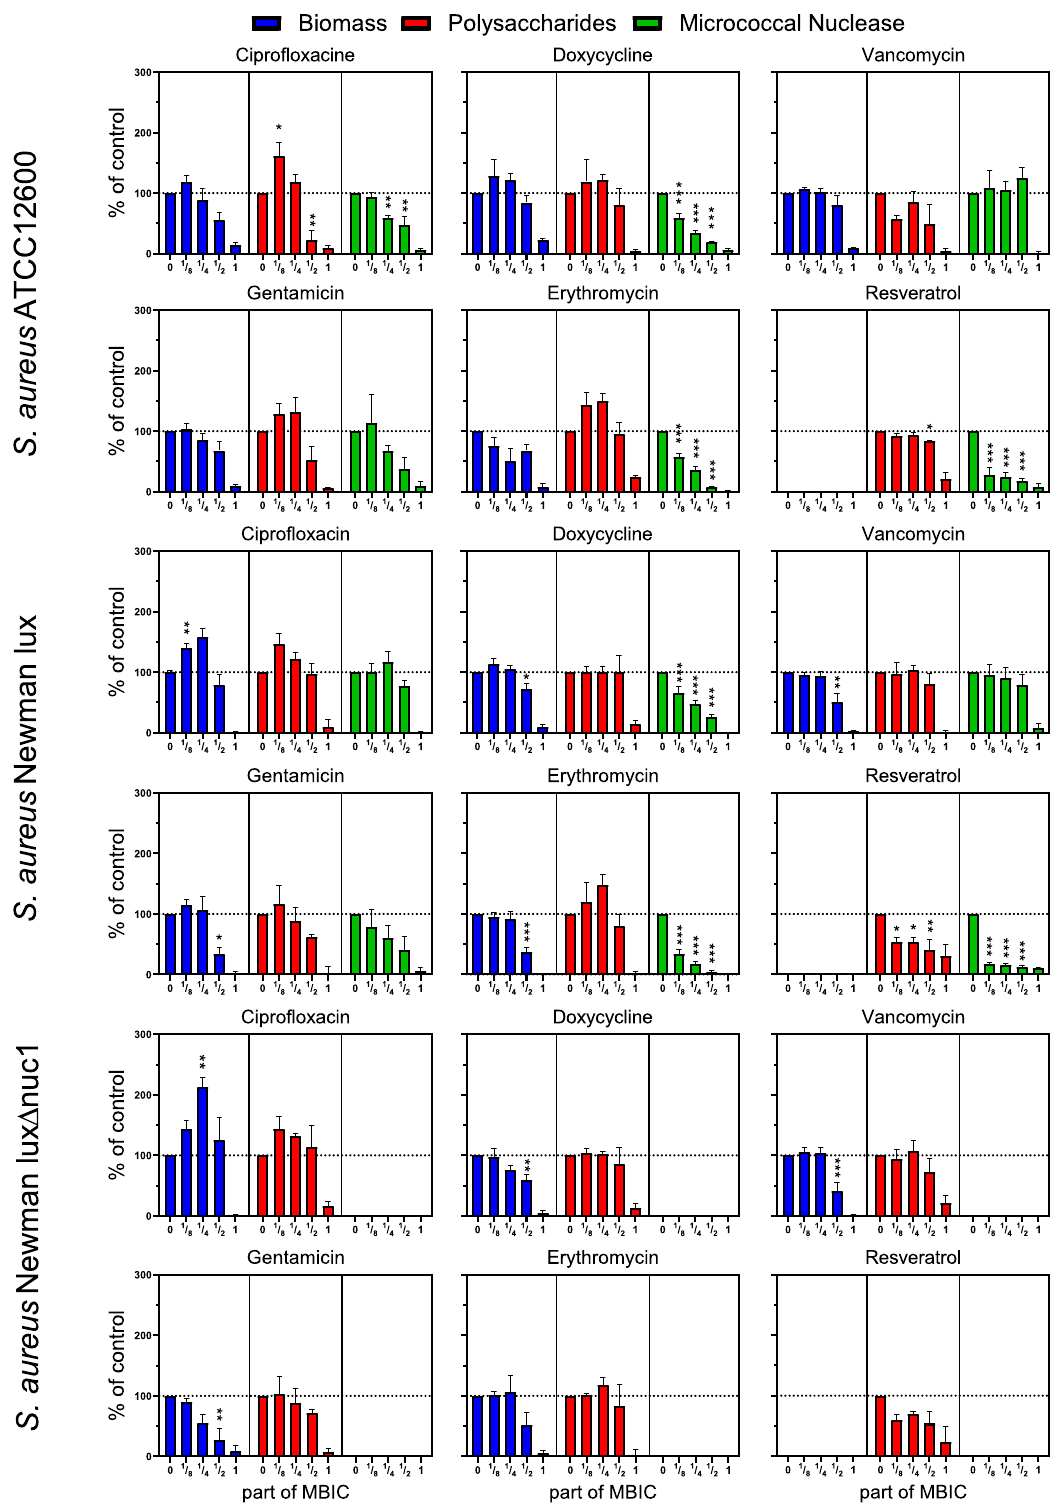
Figure 2. Biomass, polysaccharides and micrococcal nuclease (MN) activity of S. aureus ATCC12600, Newman lux, and Newman lux Δnuc1 biofilms under antimicrobial pressure (at 0, 1/8, are normalized to a control culture without antimicrobials (= 100%; horizontal dotted line). No MBIC was found for resveratrol, therefore it is set at the highest attainable concentration, 512 μg/mL. Statistical differences were calculated using an ANOVA. *Significant difference for concentrations smaller than MBIC when compared to the culture without antibiotics. (*p < 0.05; **p < 0.01; ***p <